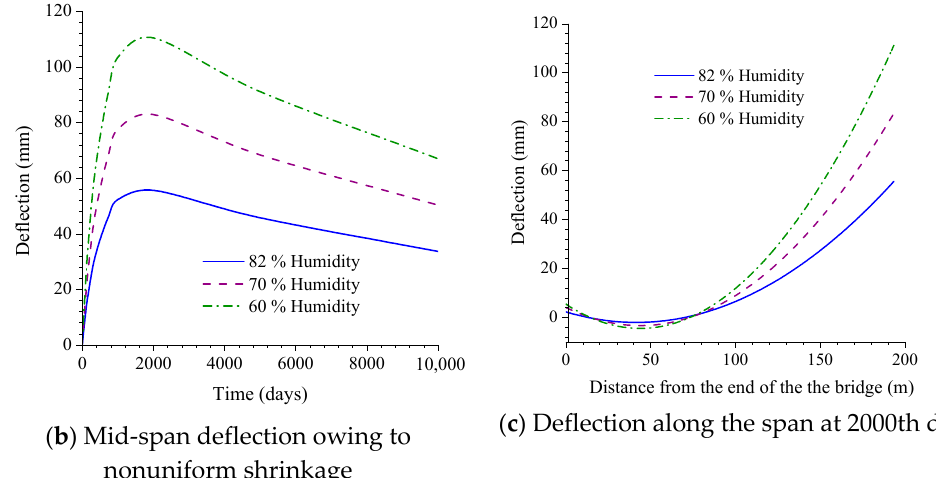
Figure 18. RH distribution in the girder section and variation of mid-span deflection owing to nonuniform shrinkage with time and along the span of Koror–Babeldaob Bridge.